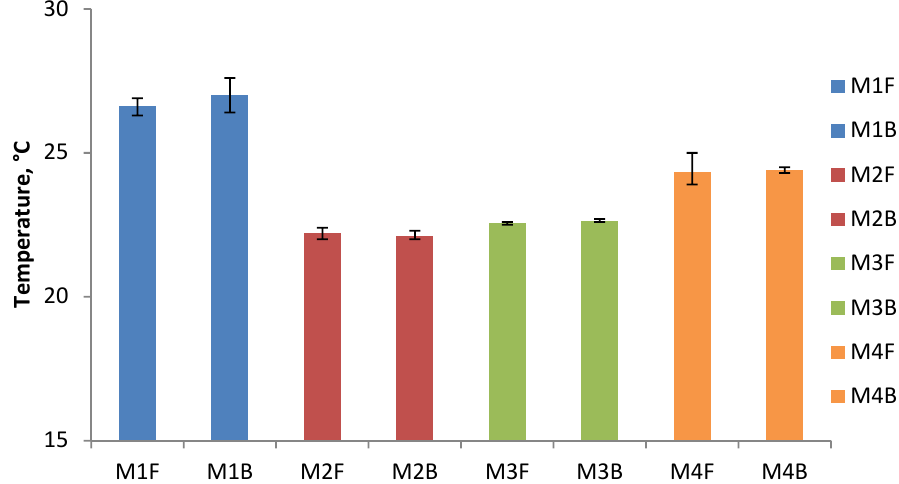
Figure 10. The results of average maximum temperature measurements on the surface of briquettes after briquetting: F—front, B—back.